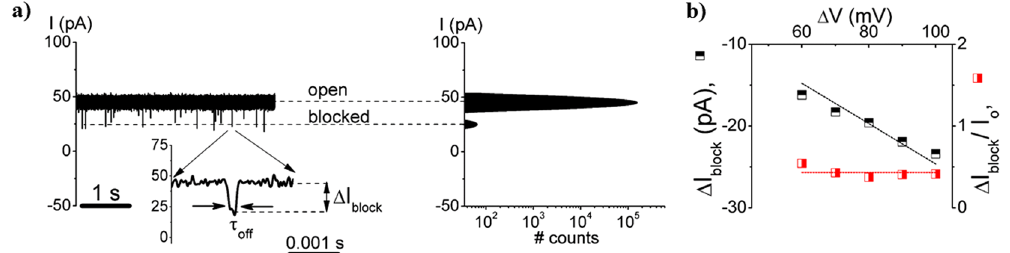
Figure 5. Representative single-channel current trace reflecting the PAMAM-G1 – α -HL interactions in 0.5 M KCl, at pH = 7. In panel a we show a typical electrophysiology trace reflecting the PAMAM-G1 – α -HL reversible blockades recorded at Δ V = + 100 mV, in 0.5 M KCl and pH = 7, and the corresponding all-events histogram. The dendrimer (500 μ M) was added on the trans side of the recording chamber. The zoomed-in trace in the inset depicts the blockade amplitude ( Δ I block ) and the corresponding duration ( τ off ), for a single PAMAM-G1 – α -HL interaction event. In panel b we illustrate the Δ I block vs. Δ V dependence (‘ ⬒ ’ – ‘up-filled squares’) and that of the relative current blockade ( Δ I block /I o ) vs. Δ V (‘ ◨ ’ – ‘right-filled